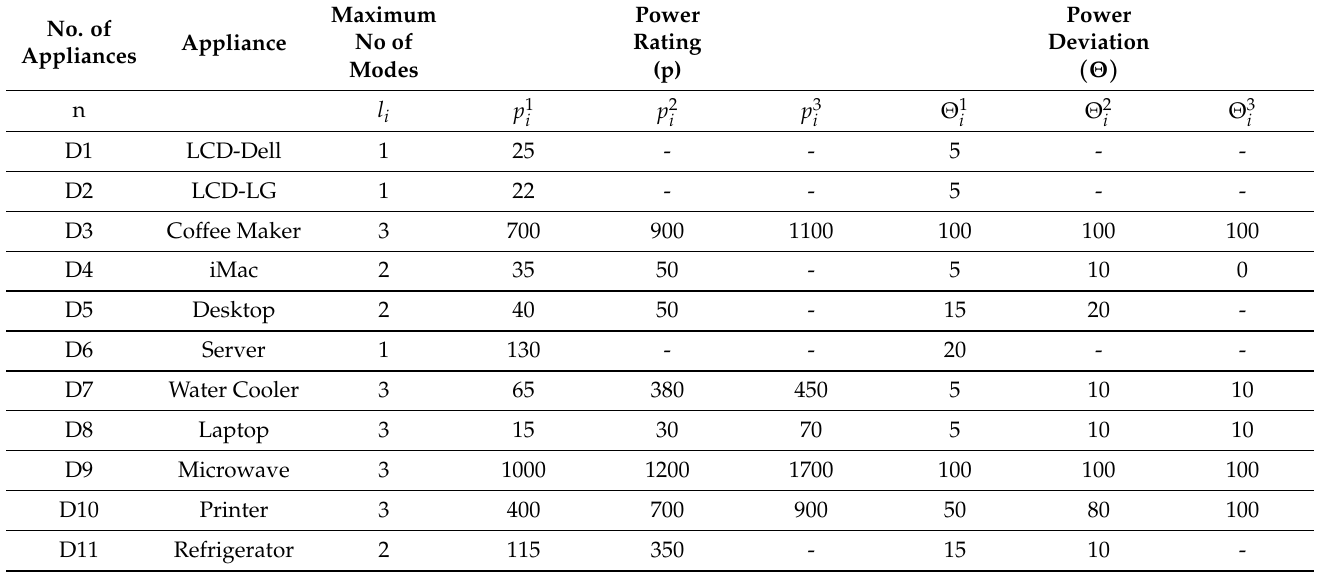
Table 1. Details of appliances, their modes of operation with associated power ratings, and their power deviations